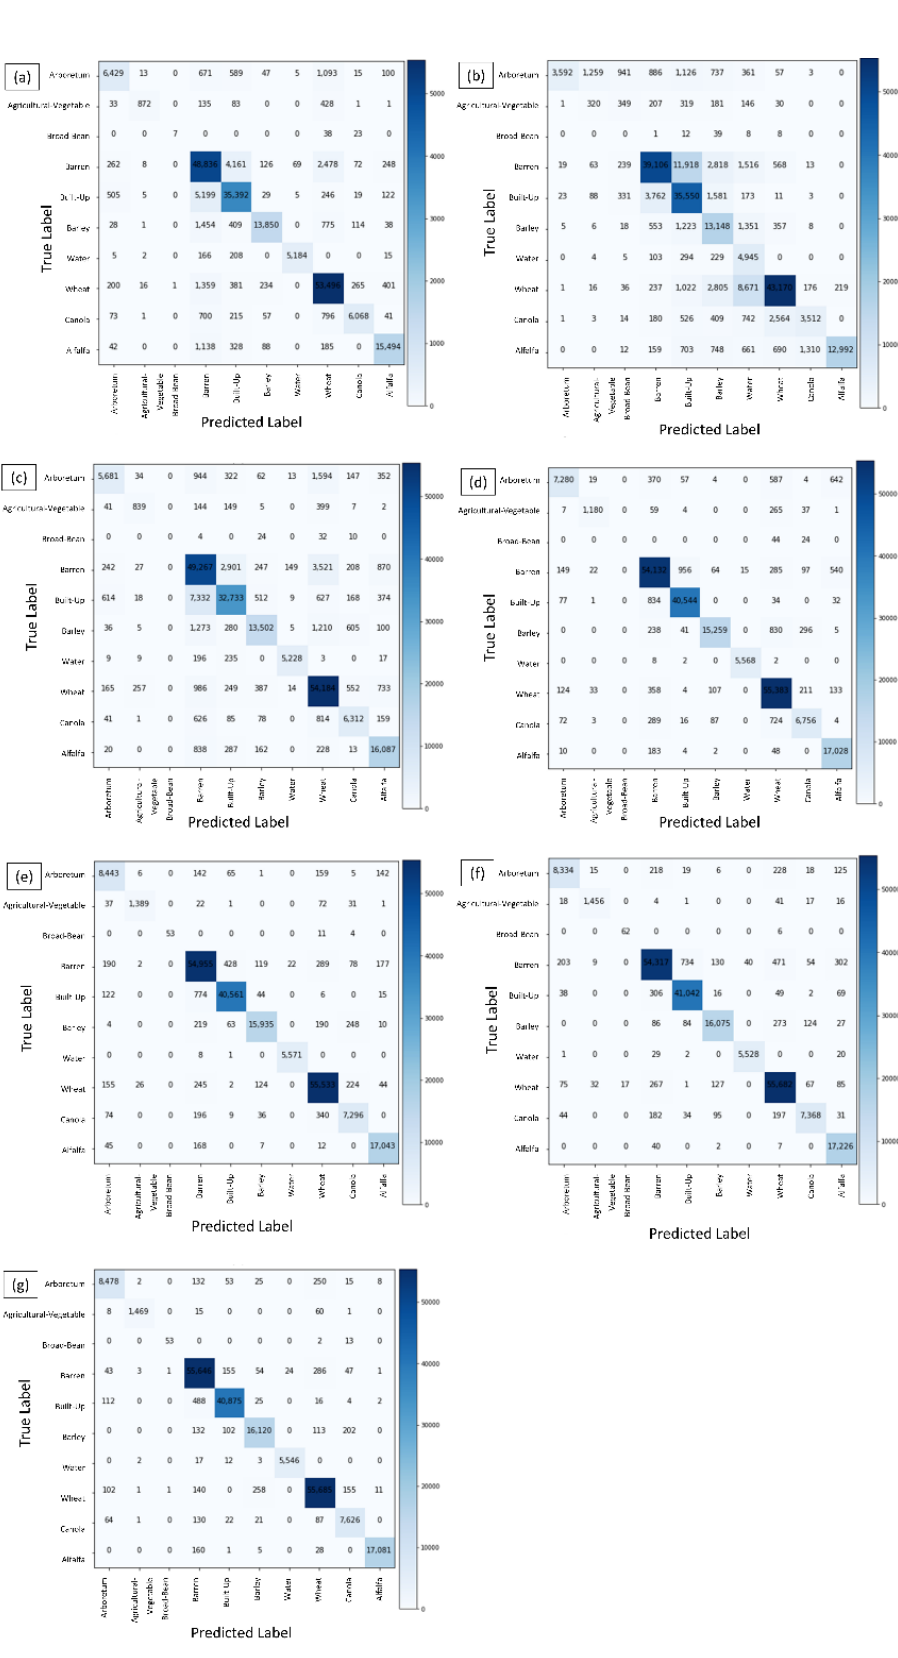
Figure 8. Comparison of the confusion matrices of different classification algorithms for crop map- ping: ( a ) XGBOOST, ( b ) RF, ( c ) R-CNN, ( d ) 2D-CNN, ( e ) 3D-CNN, ( f ) deep learning with an CBAM attention block, and ( g ) proposed method.